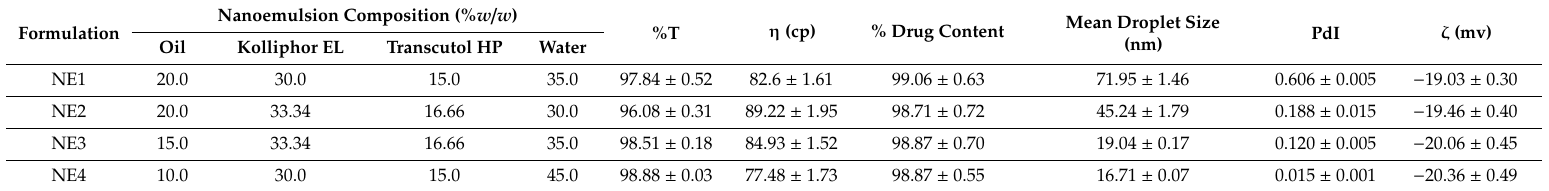
Table 3. Formulation composition and characterization of retinyl palmitate-loaded